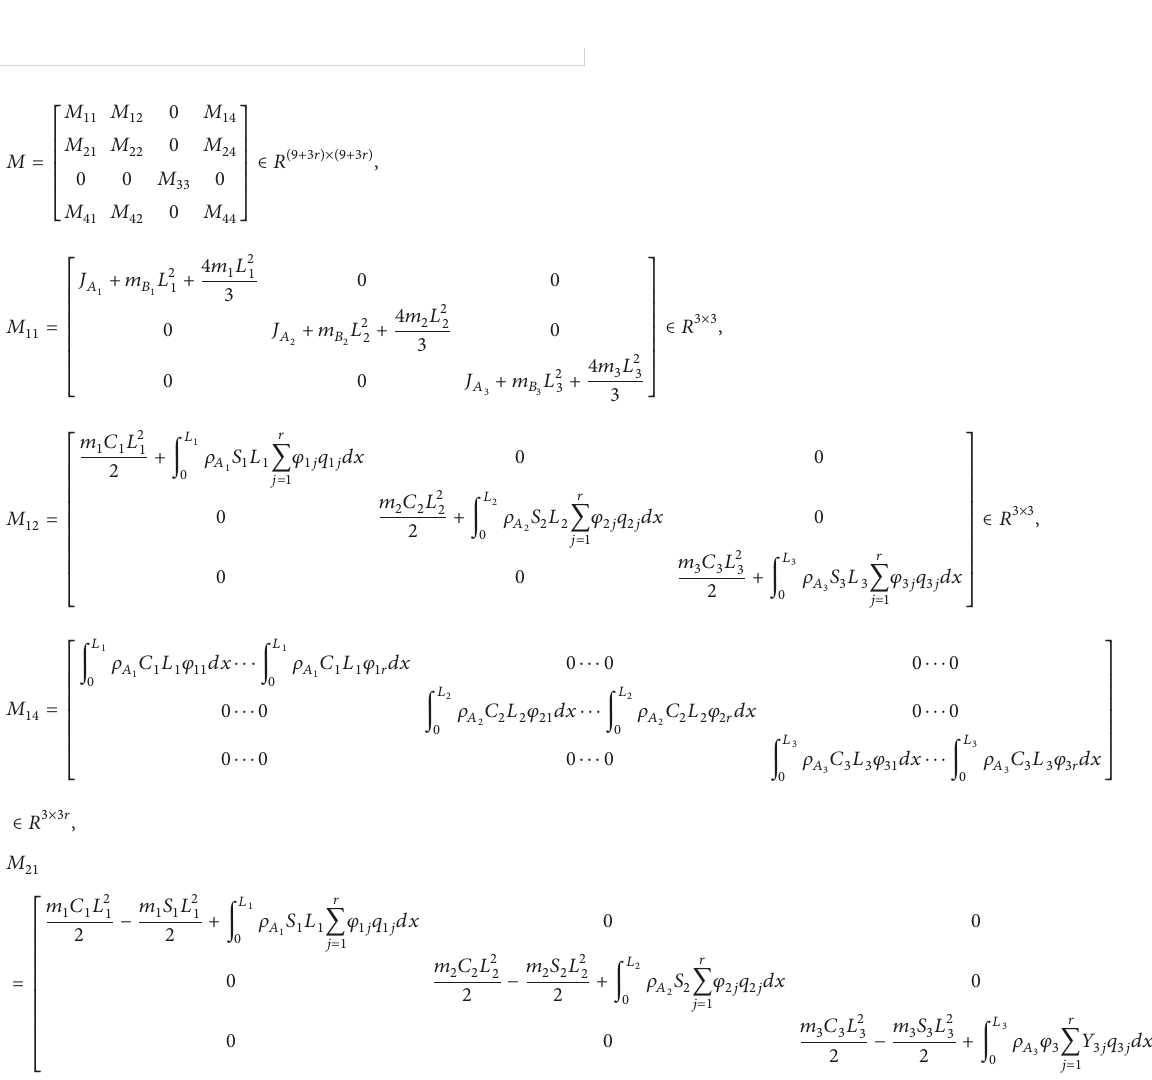
Figure 9: Modal test